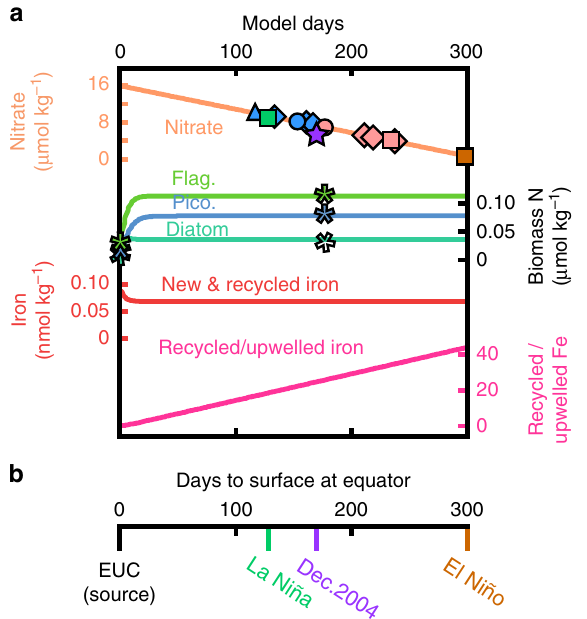
Fig. 4 Biogeochemical model of upwelled equatorial water. a The output of a numerical box model following the nutrient transformations shown in Fig. 3 shows the observed decline in nitrate and increase in phytoplankton biomass nitrogen (N) at our study site 14, 25 . Model dissolved iron concentrations (Fe) include both upwelled new and recycled iron and therefore do not drop to the lowest observed regional surface ocean values ( ≈ 0.02 nmol kg − 1 ) 11, 12 . The ratio of recycled to upwelled iron indicates the degree of iron recycling required to drive the nitrate consumption. Symbols plotted over the modeled nitrate concentration indicate surface nitrate concentration observations from the seasonal stations (orange and purple symbols, Fig. 1), from December 2004 (purple star) 12 , and for La Niña (green square) and El Niño conditions (brown square) (based on ref. 19 ).